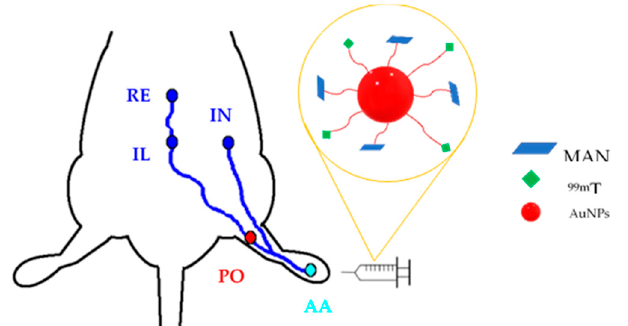
Figure 4. Illustrative picture of the 99m Tc-AuNPs-MAN 48h mapping in lymphatic vessels and nodes in a rat. The lymph nodes are identified as popliteal (PO), iliac (IL), inguinal (IN), and renal (RE). Figure 5 shows representative 3D microSPECT / CT images for Group A. Here, 99m Tc-AuNPs-MAN 48h was injected in the right footpad, while 99m Tc-AuNPs-ALA 48h was injected in the left one. Lead covers were placed at the footpads to block the signal from the injection site. The images depict a preferential accumulation of AuNPs-MAN 48h in the PO node 3 h post injection. A minimal accumulation of AuNPs-ALA 48h was observed in the left PO node, except for the third rat (R3 in the figure). In this rat, accumulation in the IL and right IN nodes was also noticed. These results demonstrate mannose’s ability to promote gold nanoparticle retention within the lymph nodes.